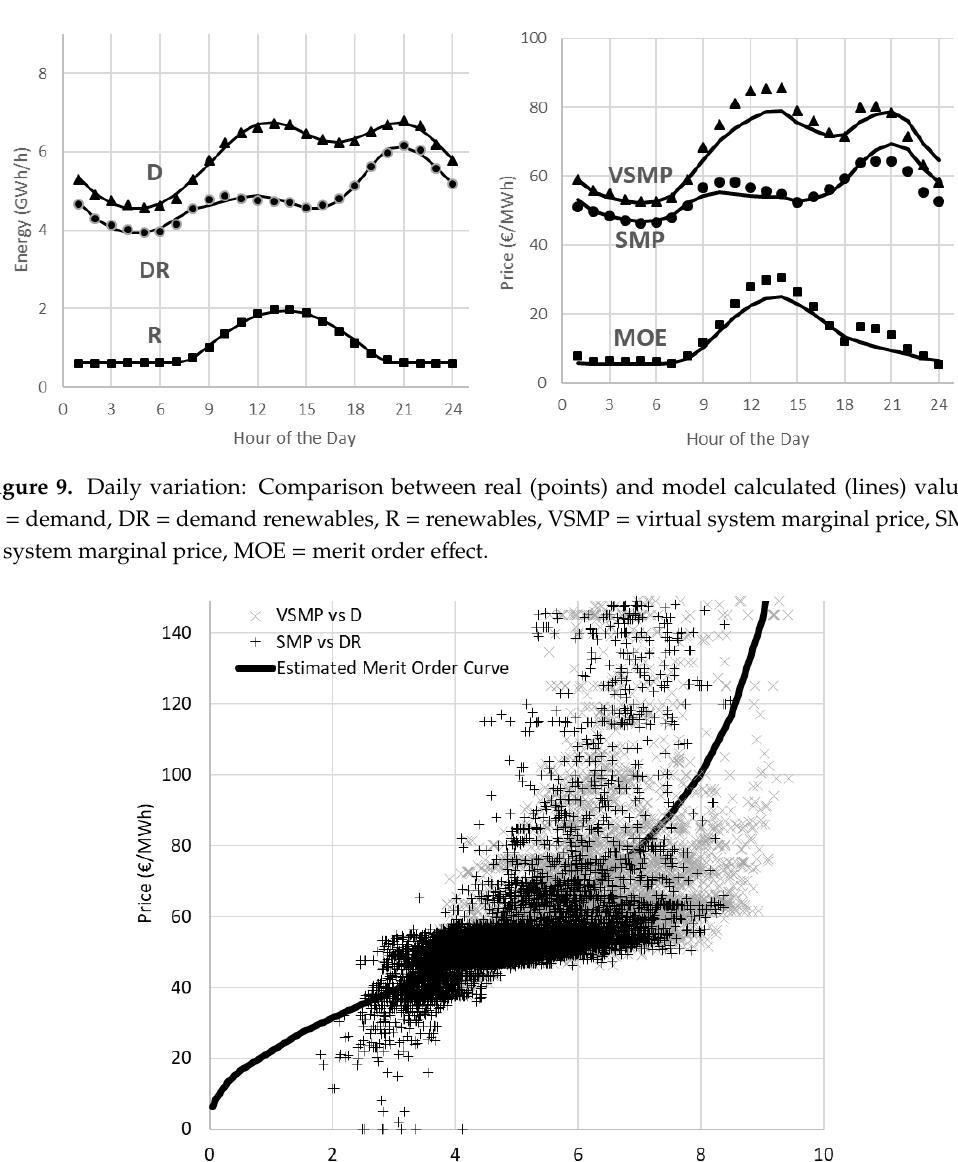
Figure 8. Seasonal variation: Comparison between real (grey lines) and model calculated (black lines)